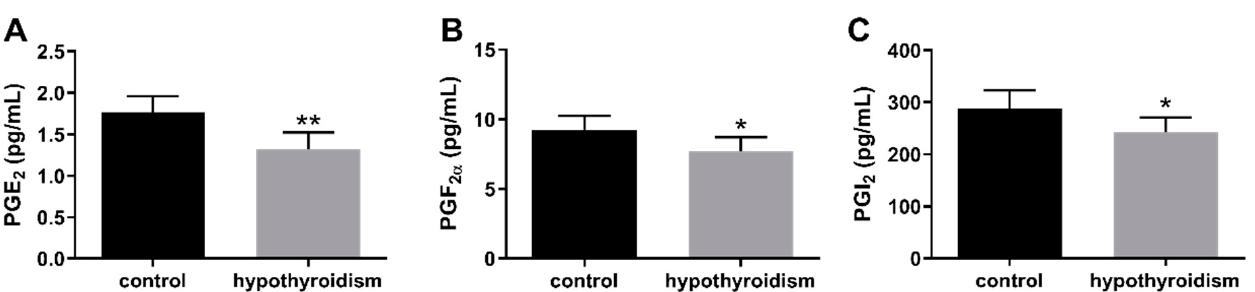
Figure 9. The effect of hypothyroidism on the concentrations (pg/mL) of PGs in uterine tissue of rats: ( A ): PGE 2 ; ( B ): PGF 2 α ; ( C ): PGI 2 . The values are presented in arbitrary units and expressed as the mean ± SEM. Stars indicate significant differences (* p ≤ 0.05, ** p ≤ 0.01, *** p ≤ 0.001, **** p ≤ 0.0001), as determined by Student’s t -test.